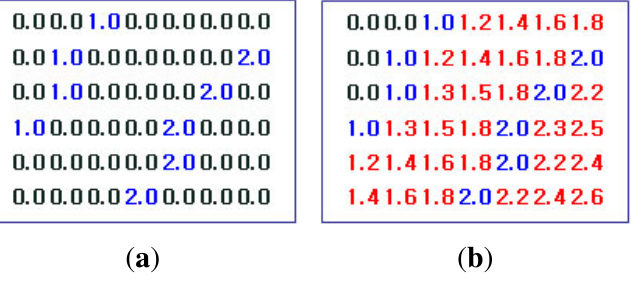
Figure 9. Code generation and interpolation: ( a ) code of thinned lines; and ( b ) linear code